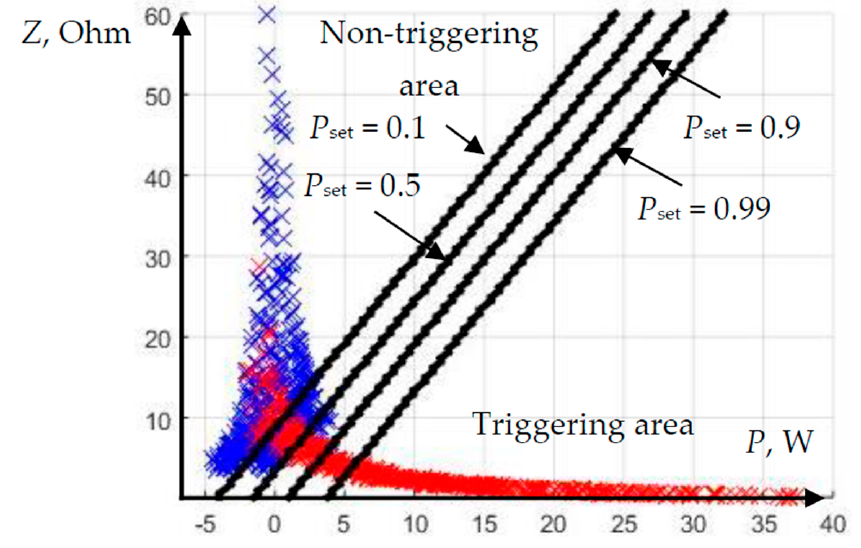
Figure 9. Family of trigger limits obtained at different values of the setpoint p .